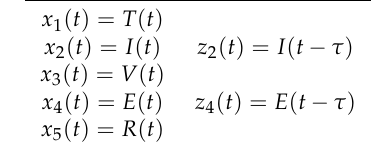
Table 2. Correspondence between labeling of the state variables in Models (1) and